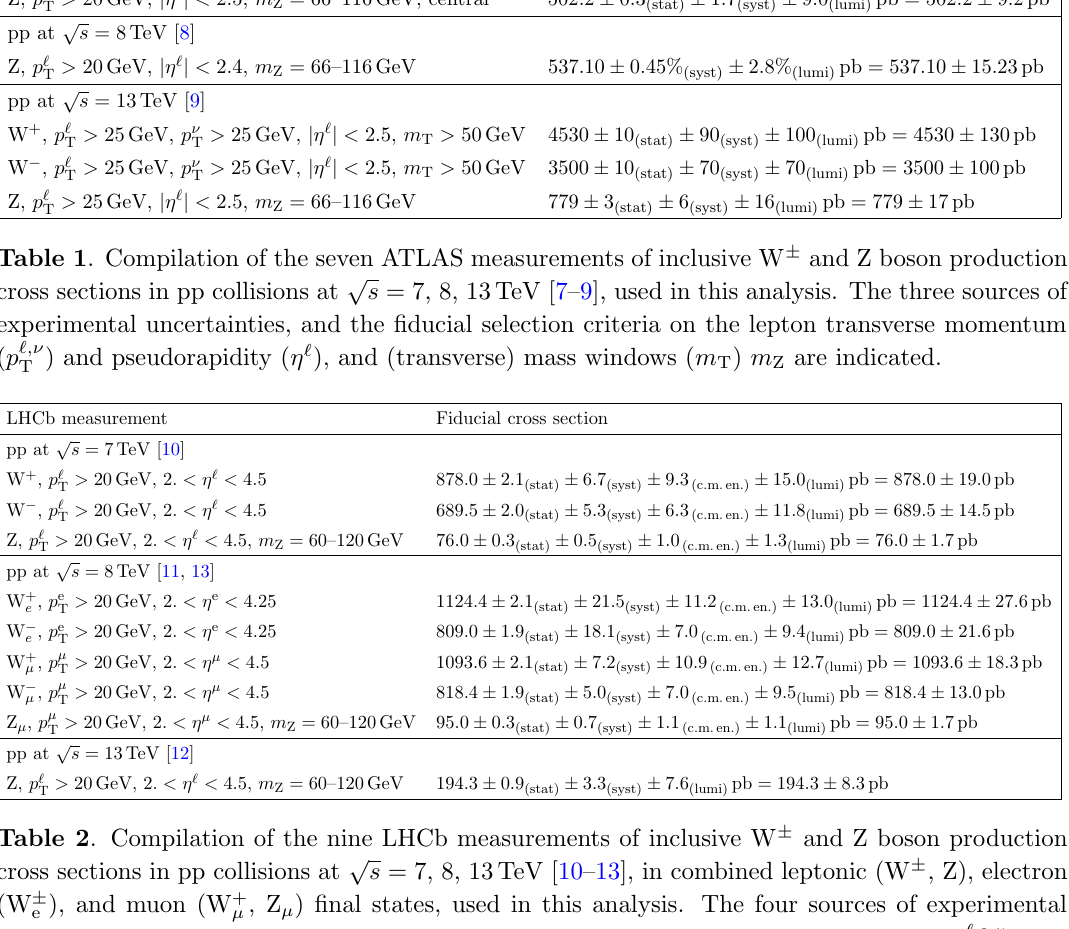
(table 3) the CDF and D0 measurements, 3 which feature 2{3 times larger experimental